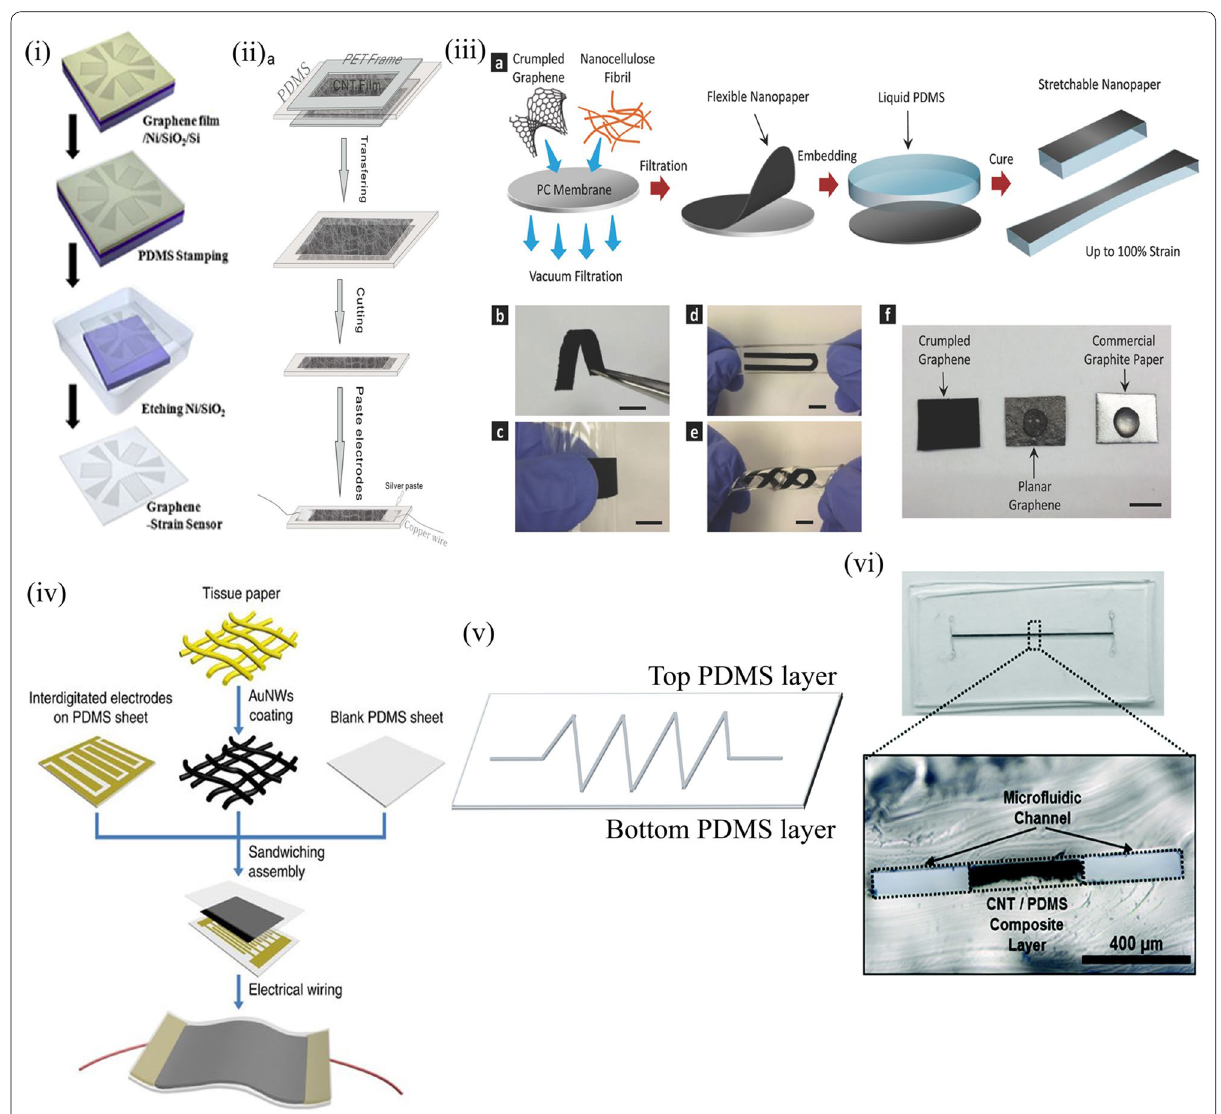
Fig. 5 Sensors obtained from composites of conductive fillers in (i) Graphene film deposition (Reproduced by permission from [184]